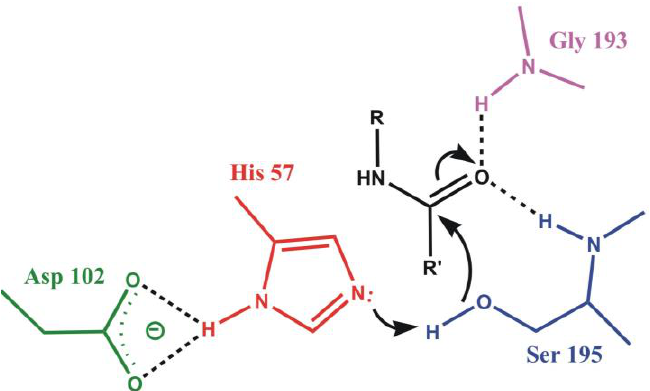
Figure 3. The oxyanion hole stabilizing the tetrahedral intermediate in α-chymotrypsin. Backbone amide NH groups of Gly193 and Ser195 form hydrogen bonds with the amide oxygen atom of the